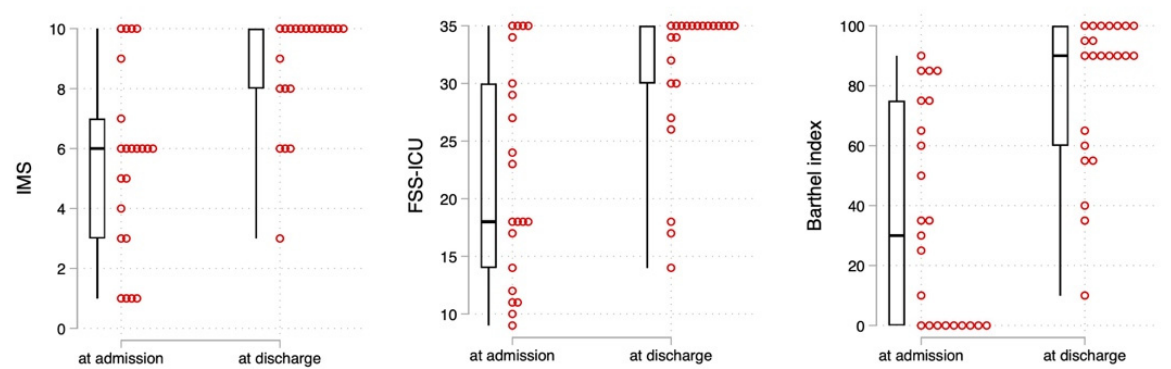
Figure 2. Box and dot plots of changes in physical function and ADL from hospital admission to discharge. MRC = medical research council, SPPB = short physical performance battery, IMS = intensive care unit mobility scale, FSS-ICU = functional status score for the ICU.